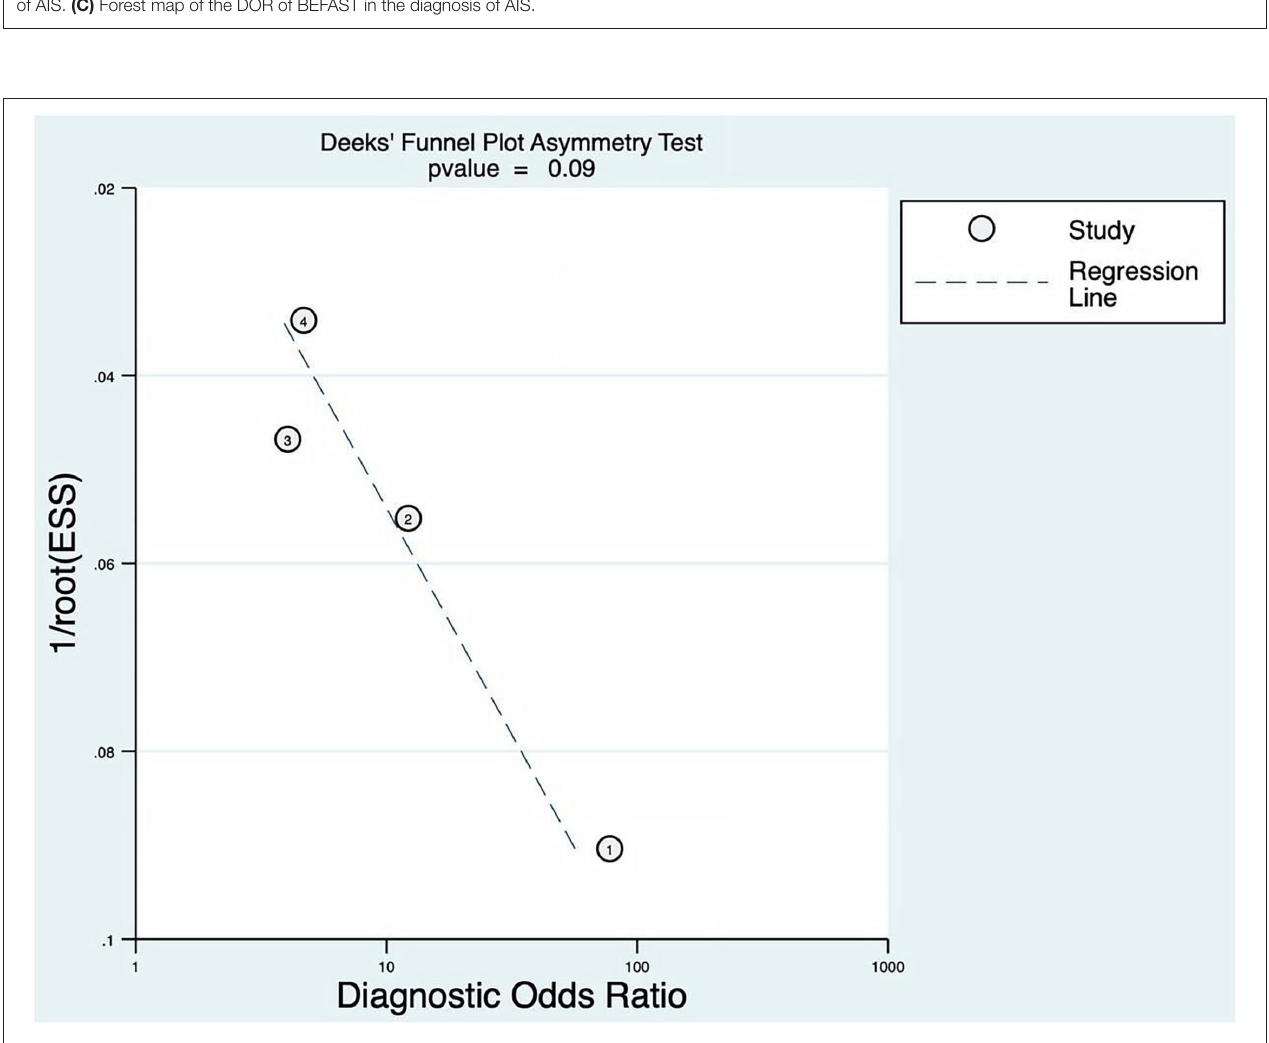
data, practice data, or clinical judgment. Post-test probabilities are used to determine whether the probability of diagnosis has raised or fallen, compared with pre-test probabilities.